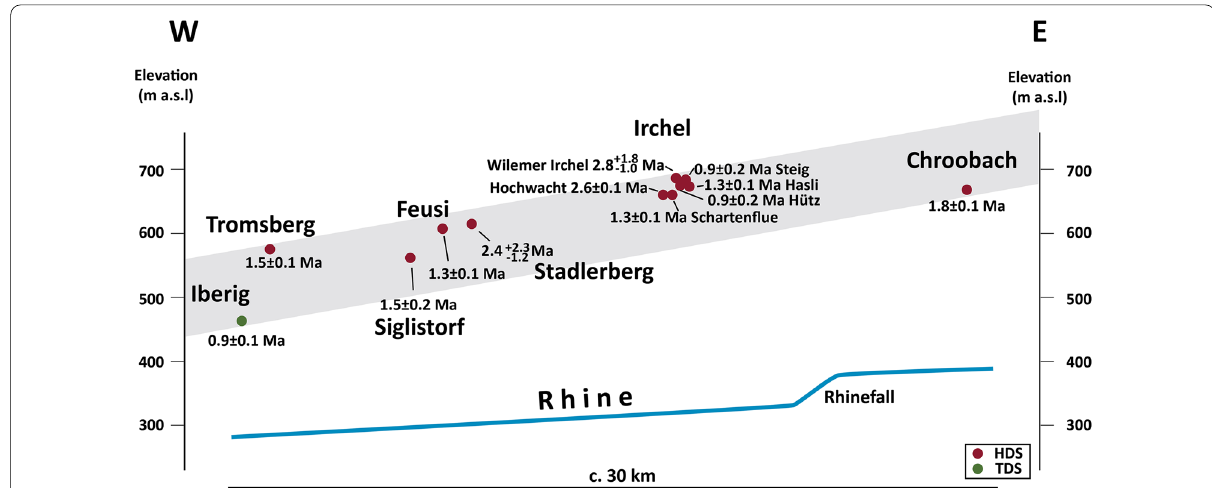
Fig. 16 Elevation vs. distance plot showing positions of the dated Deckenschotter sites (between 2.6 Ma and ca. 1 Ma) and the current base level of the Rhine (modified after Claude et al., 2019). Grey band indicates the base level of the River Rhine during the Deckenschotter times. HDS: Upper Deckenschotter Deposits; TDS: Lower Deckenschotter